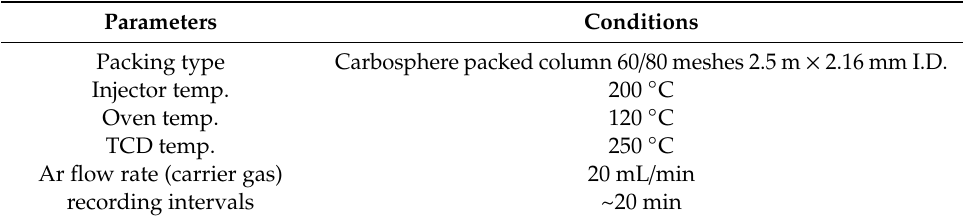
Table 2. Analytical conditions by online